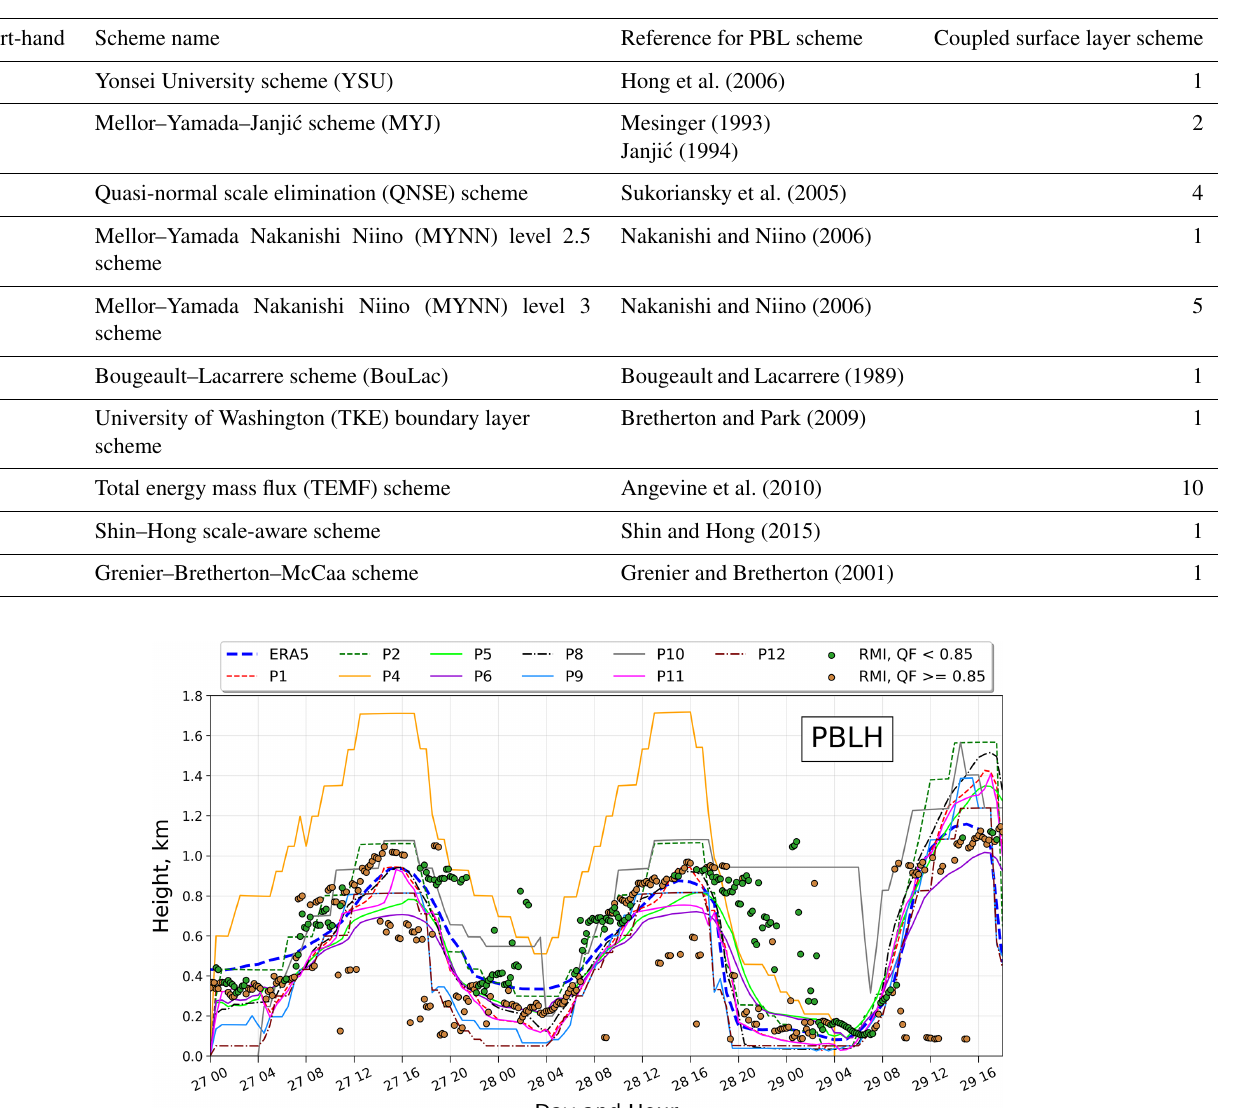
Table 3. List of WRF-Chem planetary boundary layer parameterizations and their coupled surface layer scheme tested in this study. The number in the last column identifies the surface layer scheme, as defined in the WRF documentation (Skamarock et al., 2019). Note that schemes 7 and 99 were not tested, as scheme 7 appears incompatible with the other physical parameterizations used, and scheme 99 will be removed in future versions of the model.